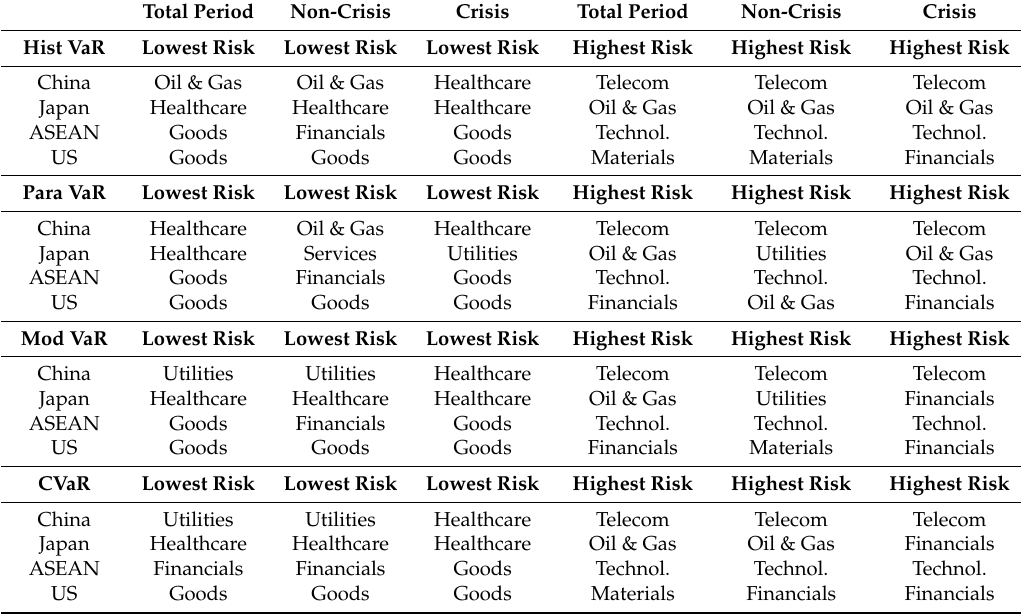
Table 1. Industries with highest/lowest risk (95%